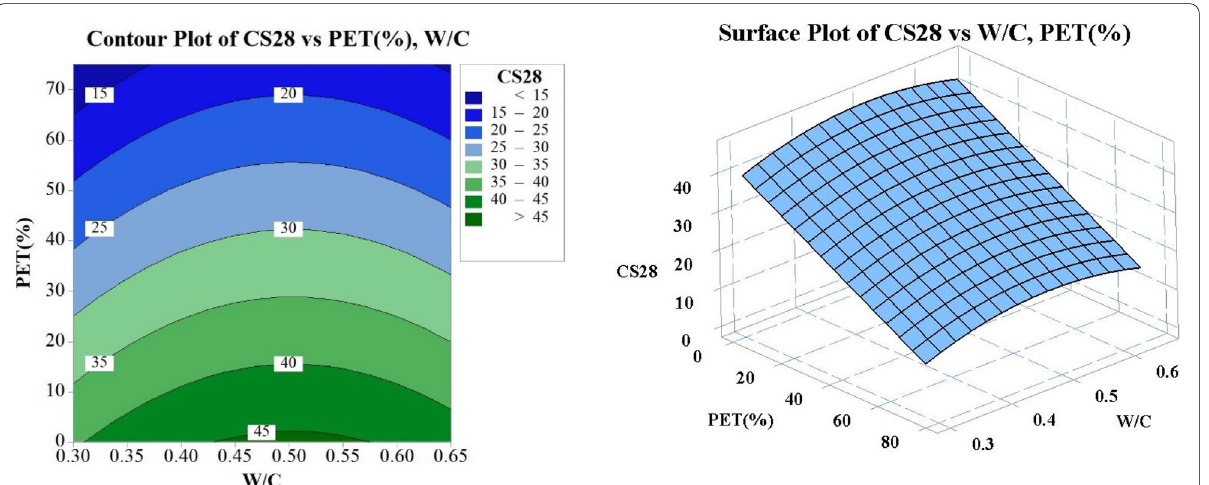
Fig. 8 Contour and surface plot of PET-FA